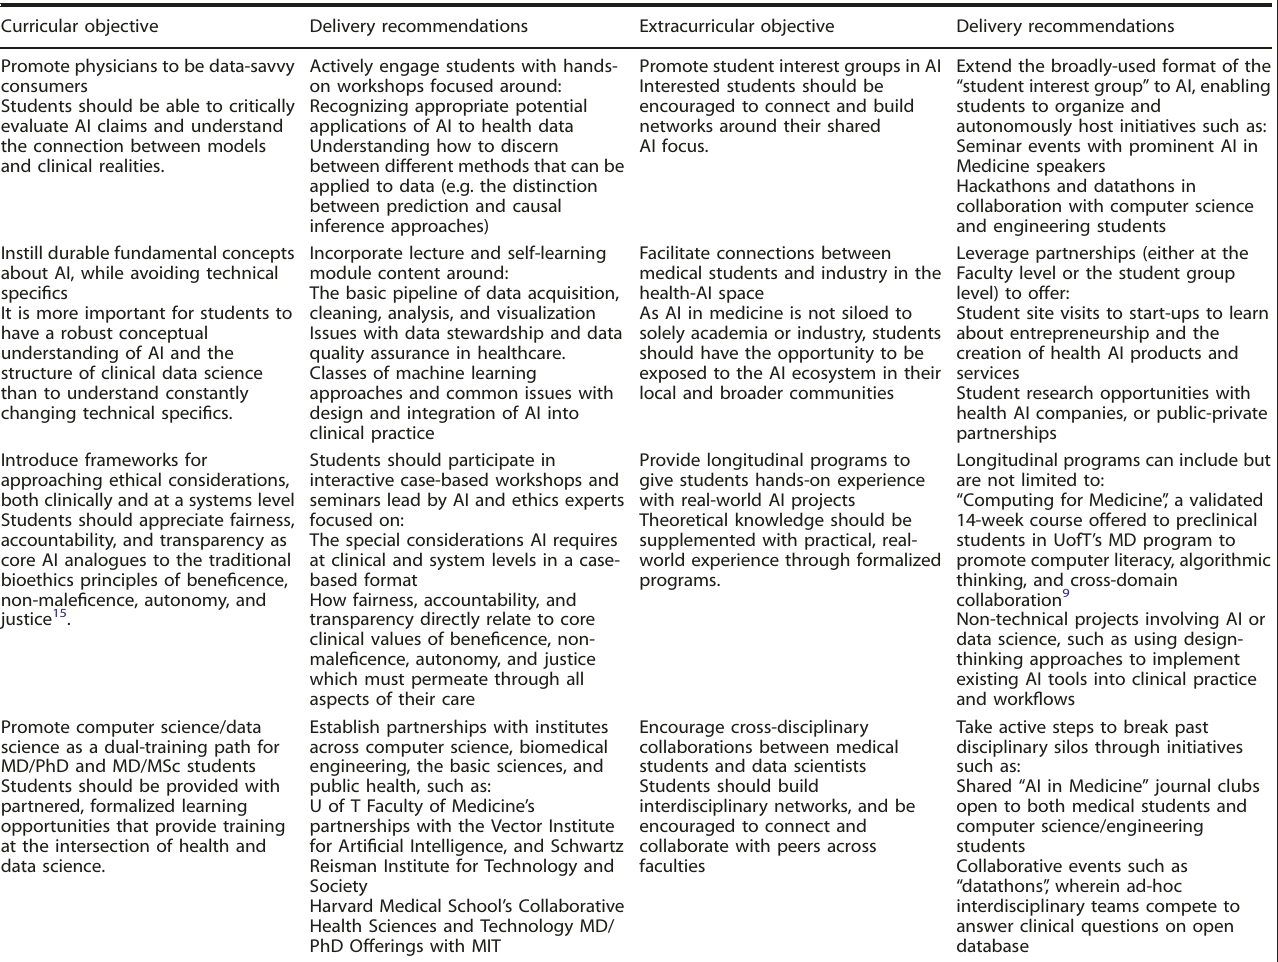
Table 1. Potential curricular and extracurricular learning opportunities for arti fi cial intelligence in